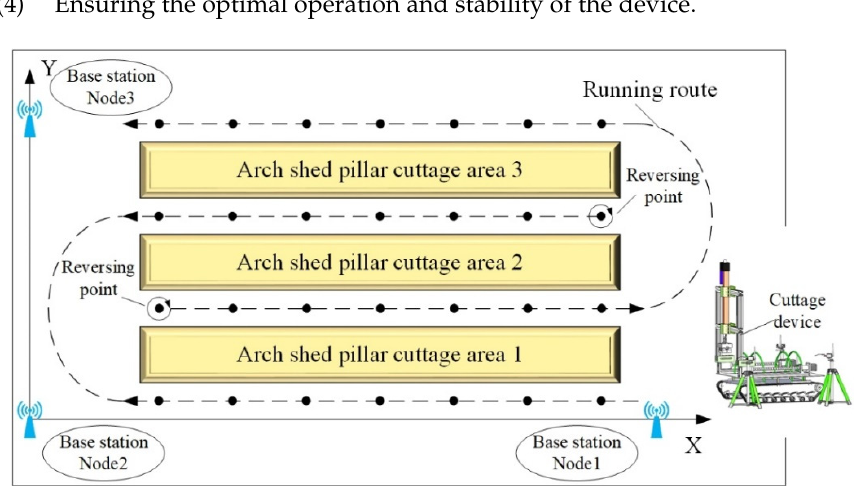
Figure 2. Automatic cutting process of arch shed pillars.